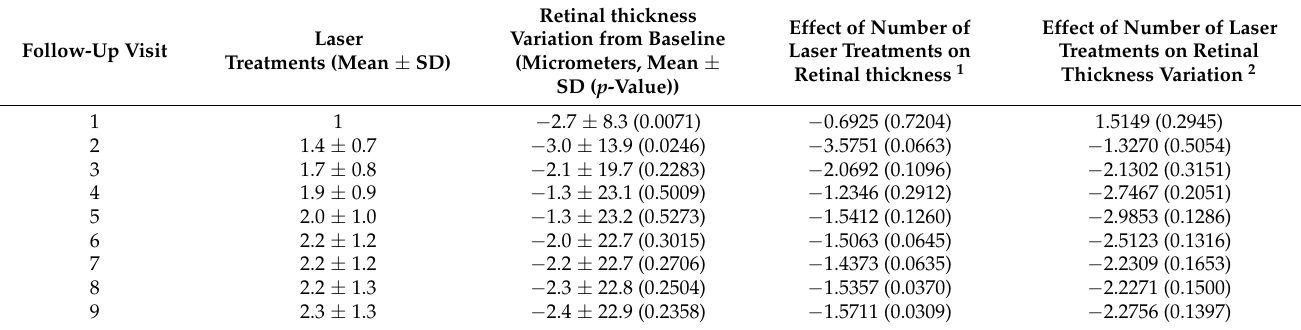
Table 3. Morphologic results at follow-up intervals: mean retinal thickness in 9 ETDRS sectors.